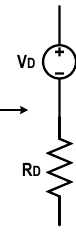
Figure 3. LED model.